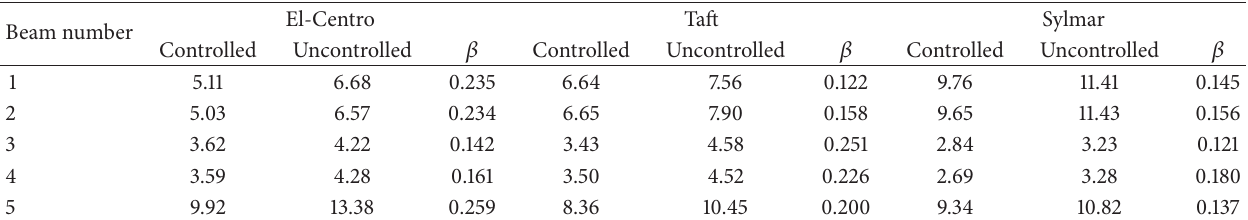
Table 5: Control effect of peak axial force under seismic excitations scaled to 0.3 g amplitude (Units in kN). Beam number